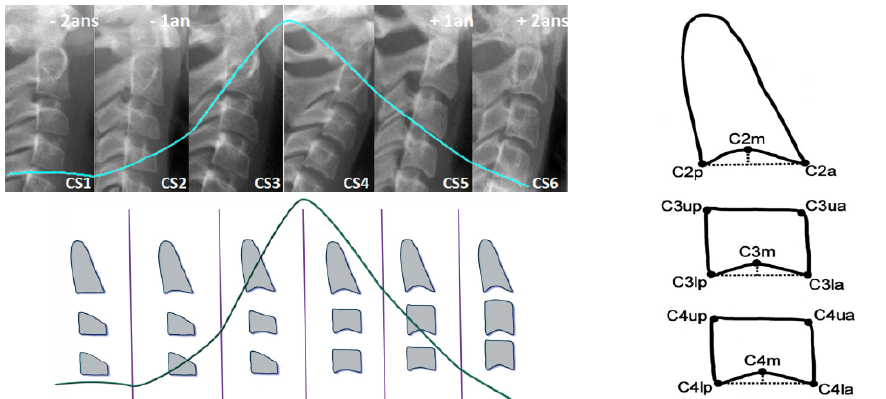
Figure 1. ( Left ) CVM radiological and morphological stages superposed with Björk growth curve [16], ( Right ) Cephalometric landmarks for CVM stages determination